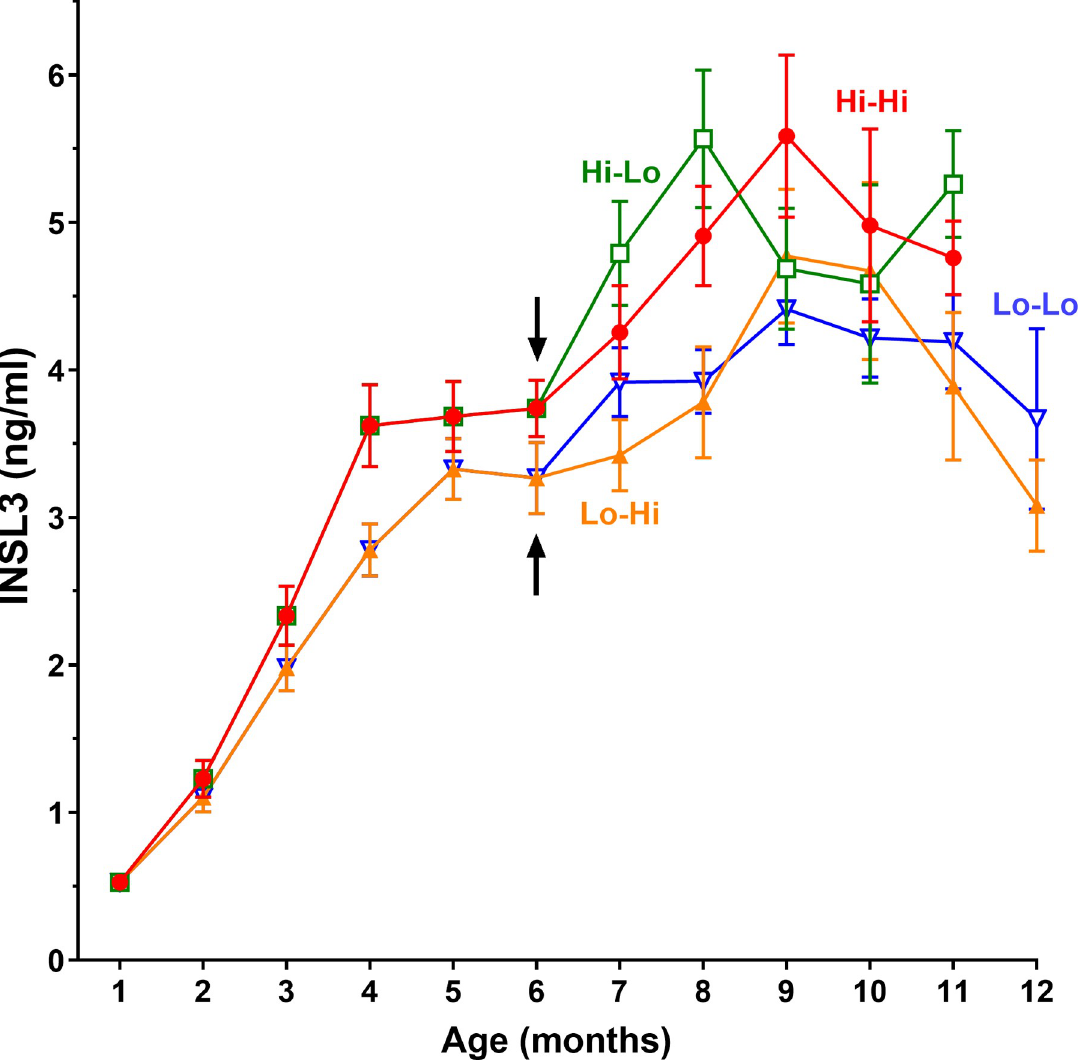
Fig 1. Profiles of INSL3 concentration in peripheral serum during the pre- and peri-pubertal periods. Up to 6 months, Holstein bull calves were fed either a high plane of nutrition (Hi) or a low plane of nutrition (Lo). At 6 months (black arrows) four groups (Hi-Hi, red circles; Hi-Lo, green squares; Lo-Hi, ochre upright triangles; and Lo-Lo, blue inverted triangles) were segregated, reflecting whether they subsequently received a Hi or Lo feeding regimen. Data are given as ng/ml (means ± SEM).